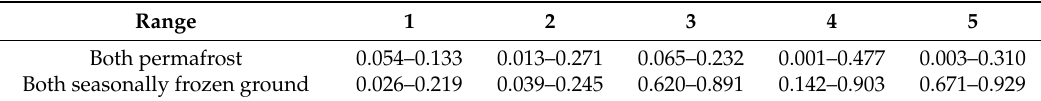
Table 2. NDVI statistics for the both classes of five latitude